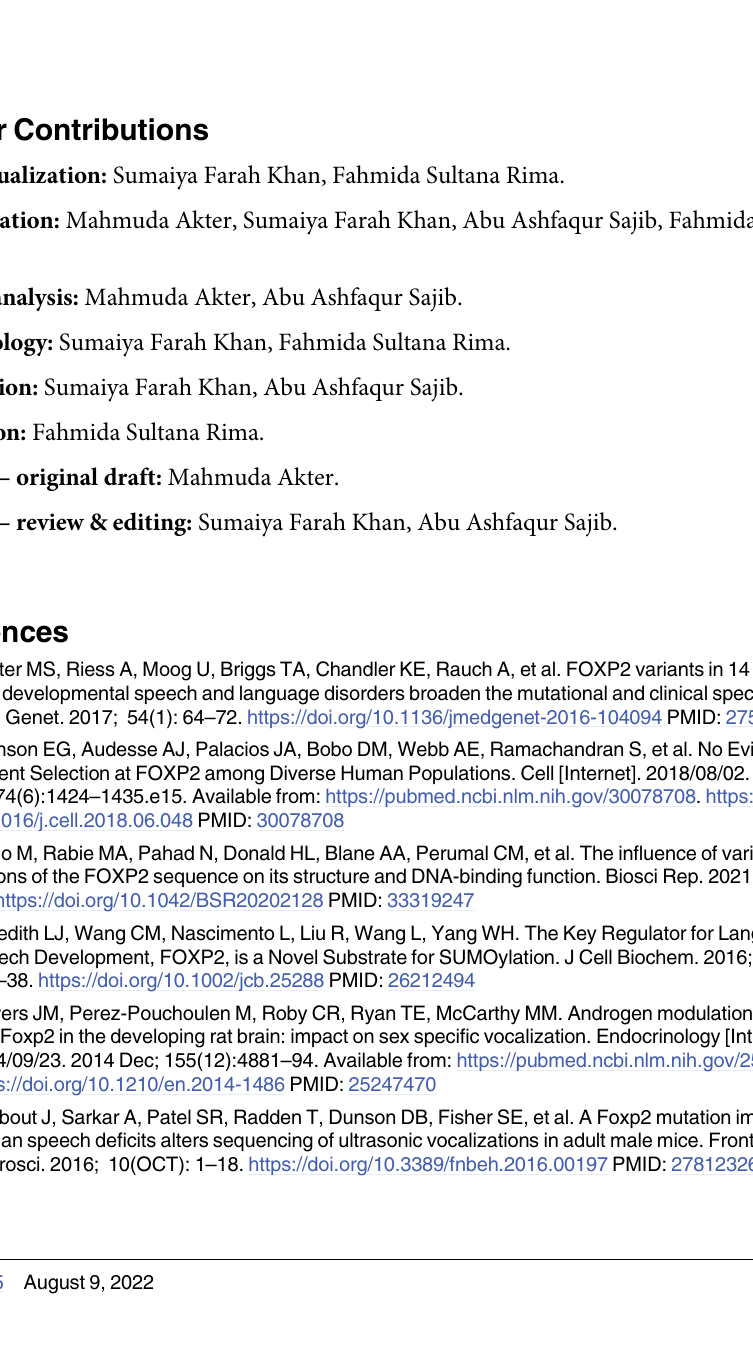
S1 Fig. Prediction of ConSurf about the conservation status of amino acids in human FOXP2 protein. S1 Table. The list of reference sequence ID, alteration of allele, protein accession no, posi- tion of amino acid and residual change of all 393 non-synonymous SNPs. S2 Table. The results of five in silico tools that are used to analyze all of the 393 non-synon- ymous SNPs. S3 Table. Interactions of amino acid residues with native and mutant FoxP2